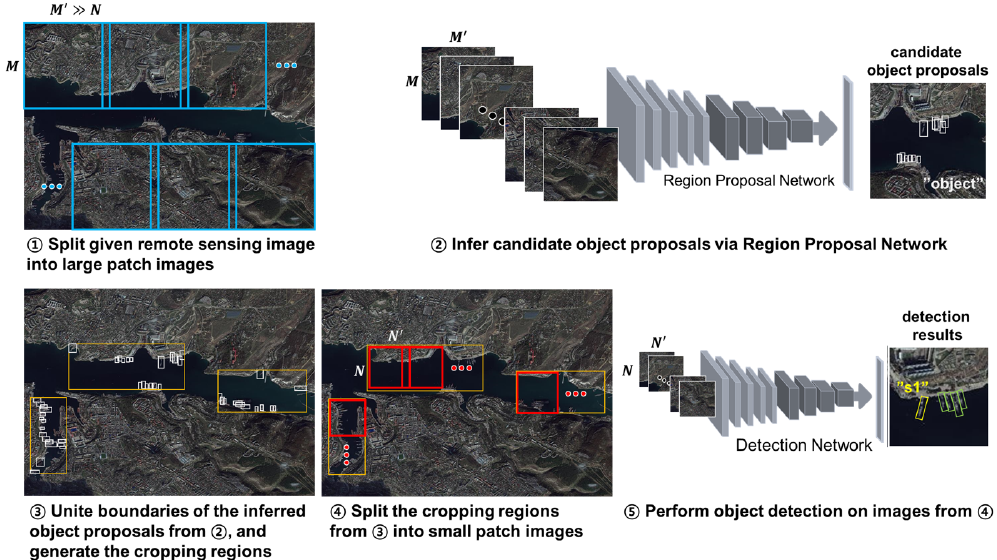
Figure 5. Illustration of clustering-guided cropping strategy. First, we quickly infer object proposals by Region Proposal Network. The boundary of each cluster crop is then determined by merging the inferred object proposals belonging to the same cluster. The cluster crops are re-explored by object detection networks in the form of set of patch